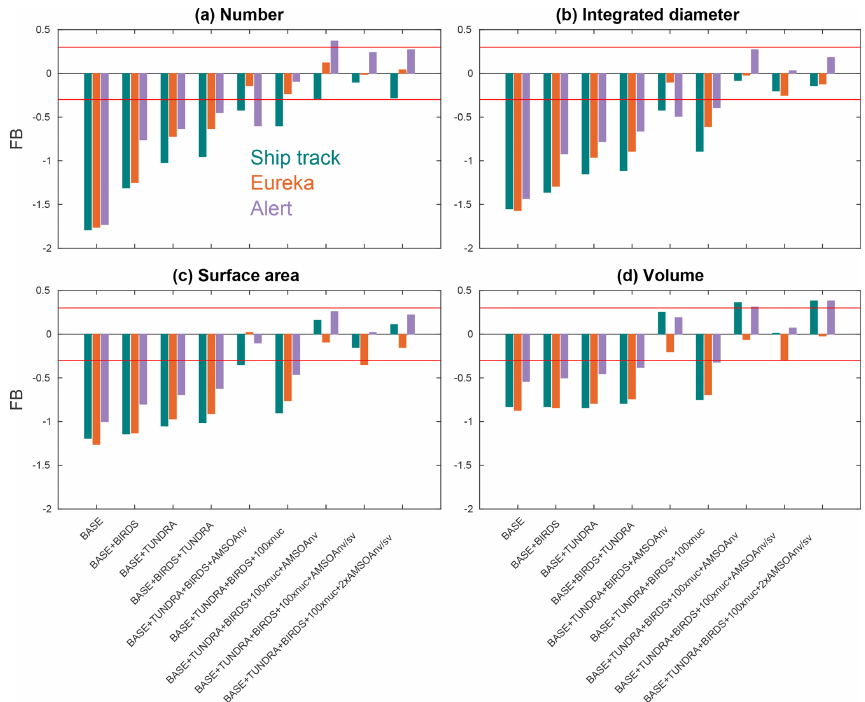
Figure 6. Fractional bias (FB; as defined in Sect. 2.2.5) between the nine GEOS-Chem-TOMAS simulations (described in Table 1 and Sect. 2.3) and the SMPS measurements (described in Sect. 2.1) for the first four moments of the summertime- (July and August 2016) median aerosol size distributions at Alert, Eureka, and during the CCGS Amundsen cruise shown in Figs. 3, 4, and 5, respectively. Color coded by geographic site (see the legend in panel (a) ). Red lines show the FB values of − 0 . 3 and + 0 . 3, which are the bounds for satisfactory model